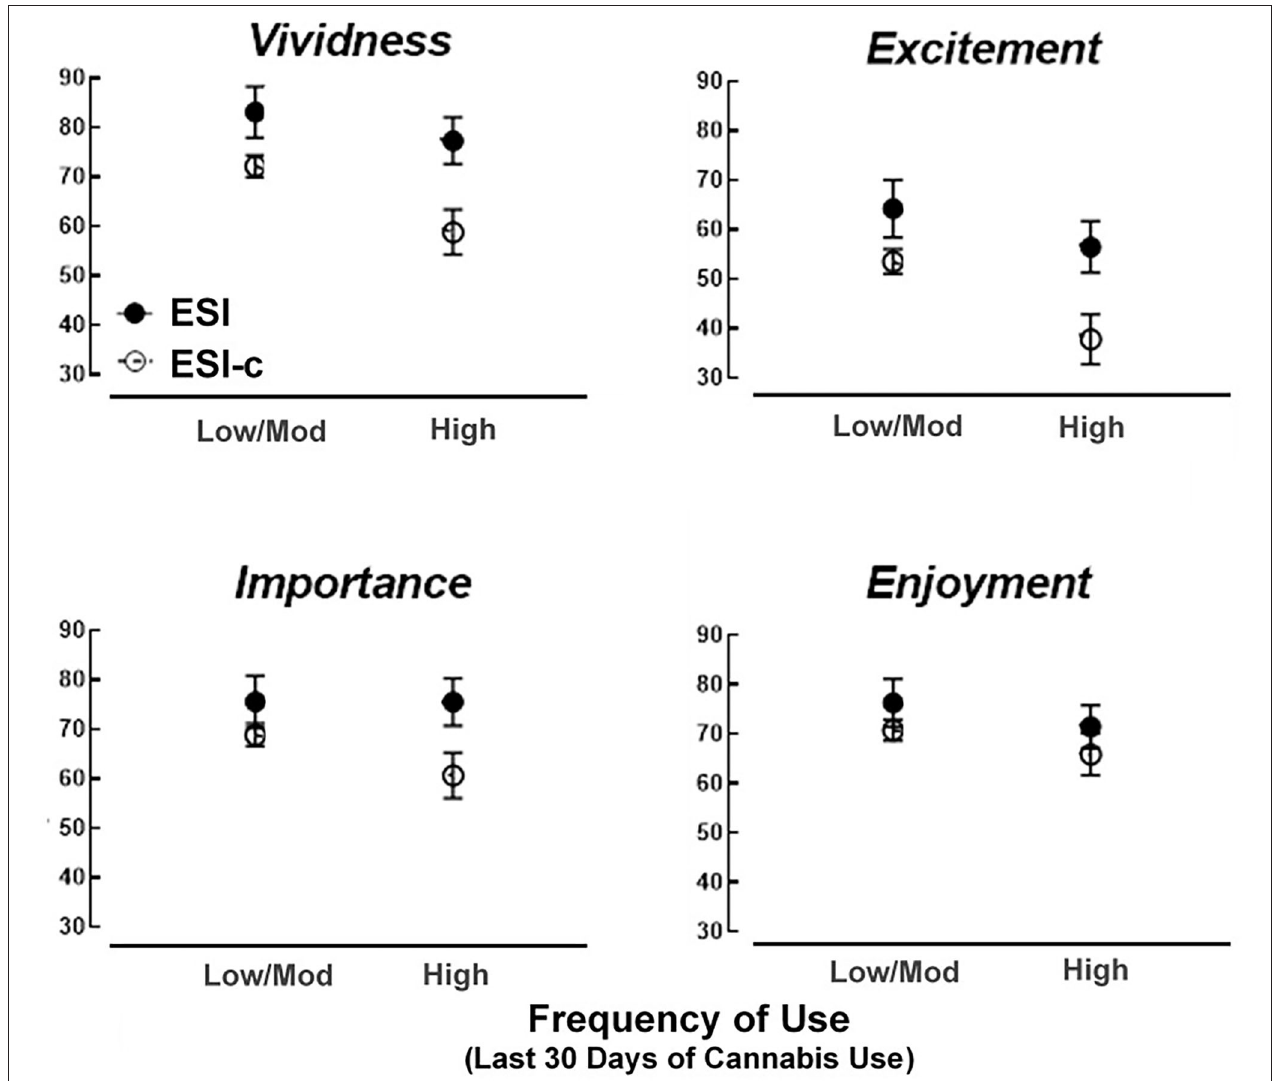
FIGURE 1 | Subjective episodic memory ratings as a function of frequency of cannabis use and ESI/ESI-c